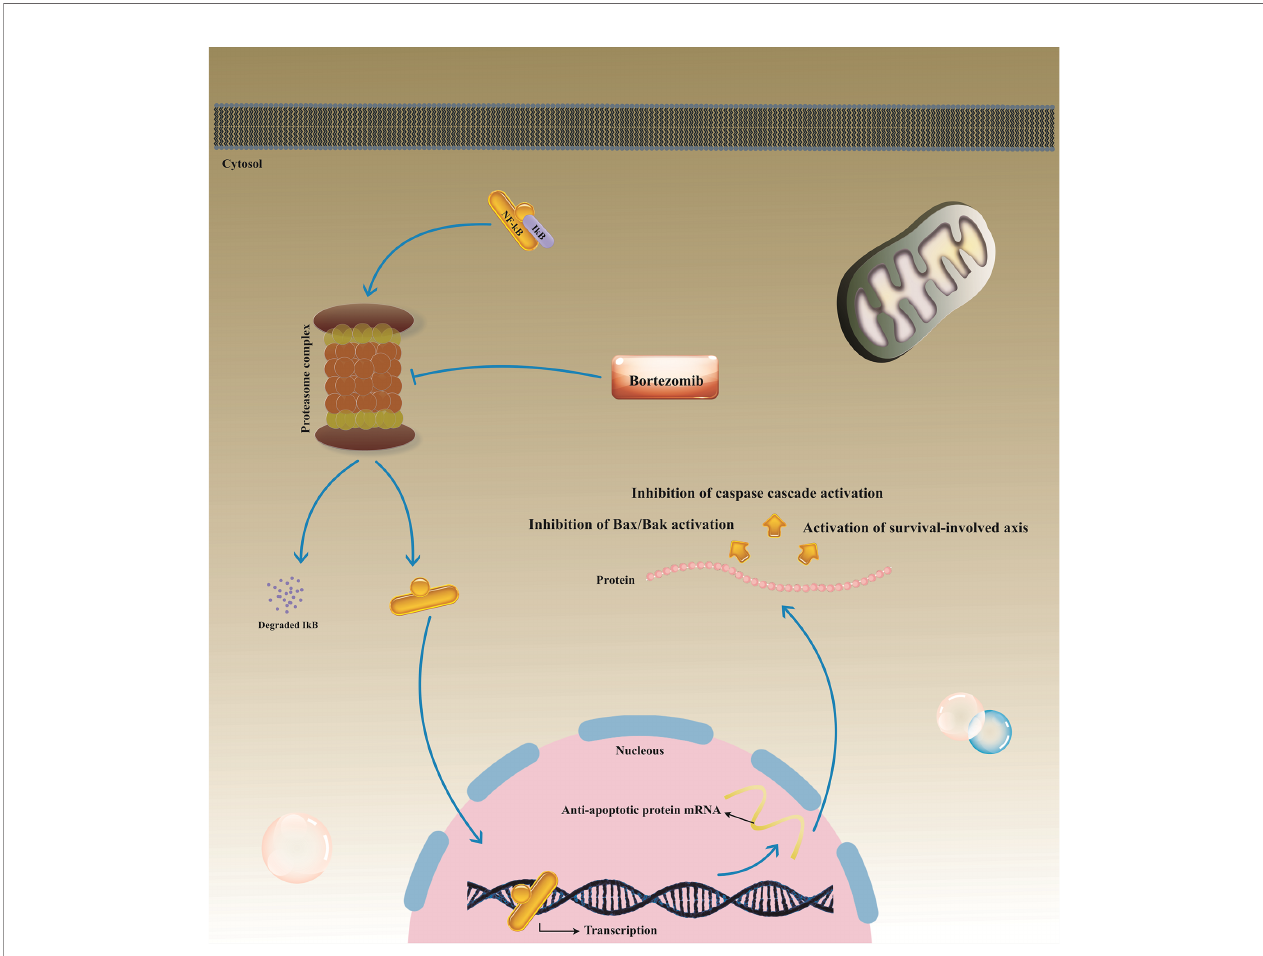
FIGURE 3 | The bortezomib-mediated process involved in inducing TRAIL-mediated apoptosis in TRAIL-resistant tumor cells. The proteasome inhibitor bortezomib prohibits NF- k B activation and consequently down-regulates anti-apoptotic protein expression in target cells, sensitizing TRAIL-resistant tumor cells to TRAIL- induced apoptosis. TRAIL, Tumor necrosis factor-related apoptosis-inducing ligand; NF - k B, Nuclear factor-kappa B; I k B, Inhibitor kappa